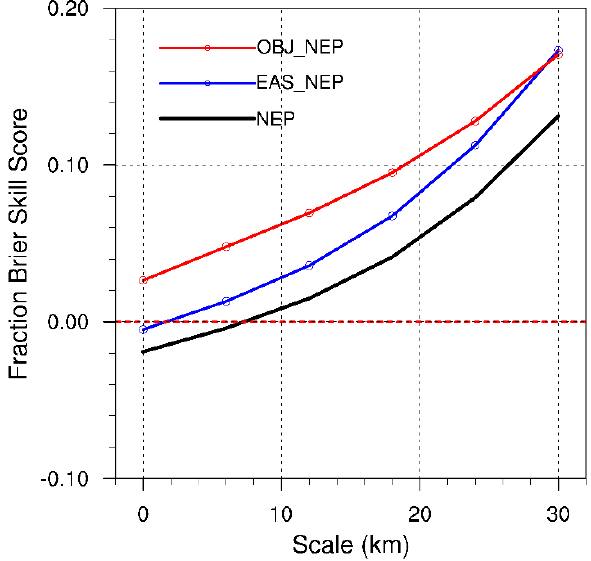
Figure 8. Graphs of Fractions Brier Skill Score (FBSS) as a function of spatial scale (km) for the NEP (black curve), EAS_NEP (blue curve), and OBJ_NEP (red curve) approaches for the idealized experiment. GP was used as the reference forecast.